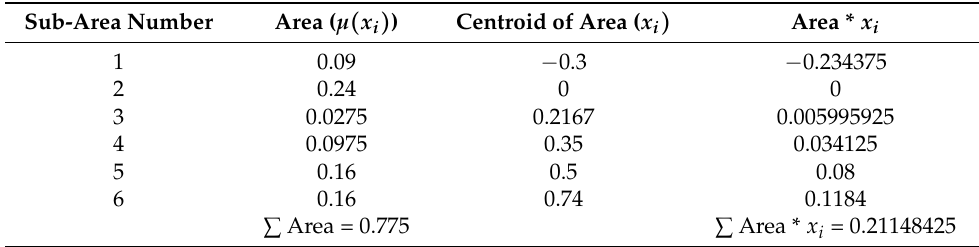
Table 2. Result of each sub-area and centroid related to example